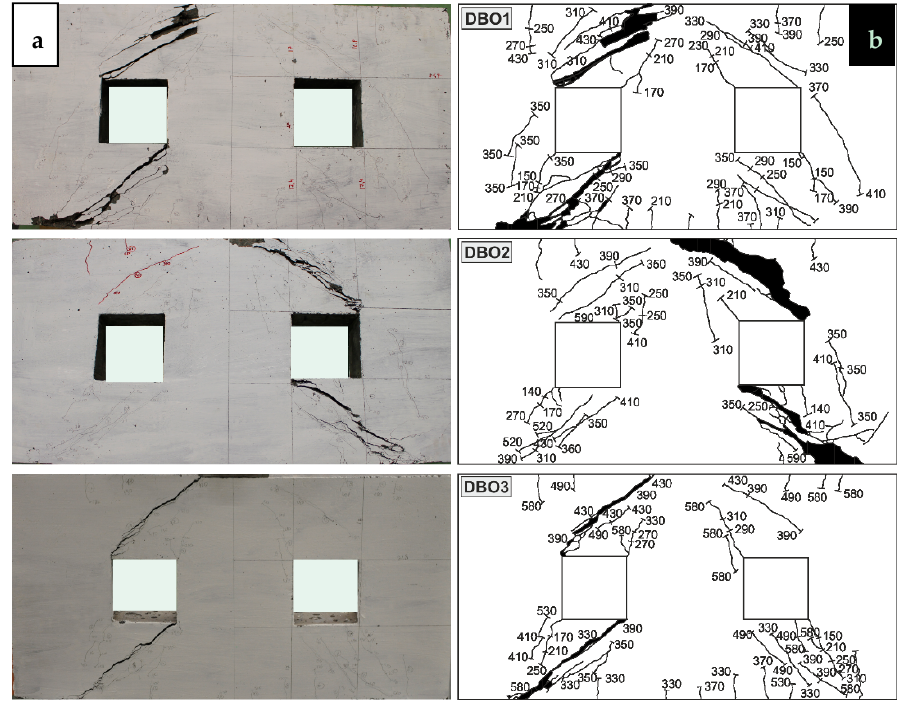
Figure 13. ( a ) Crack patterns and ( b ) crack propagation in DBO.